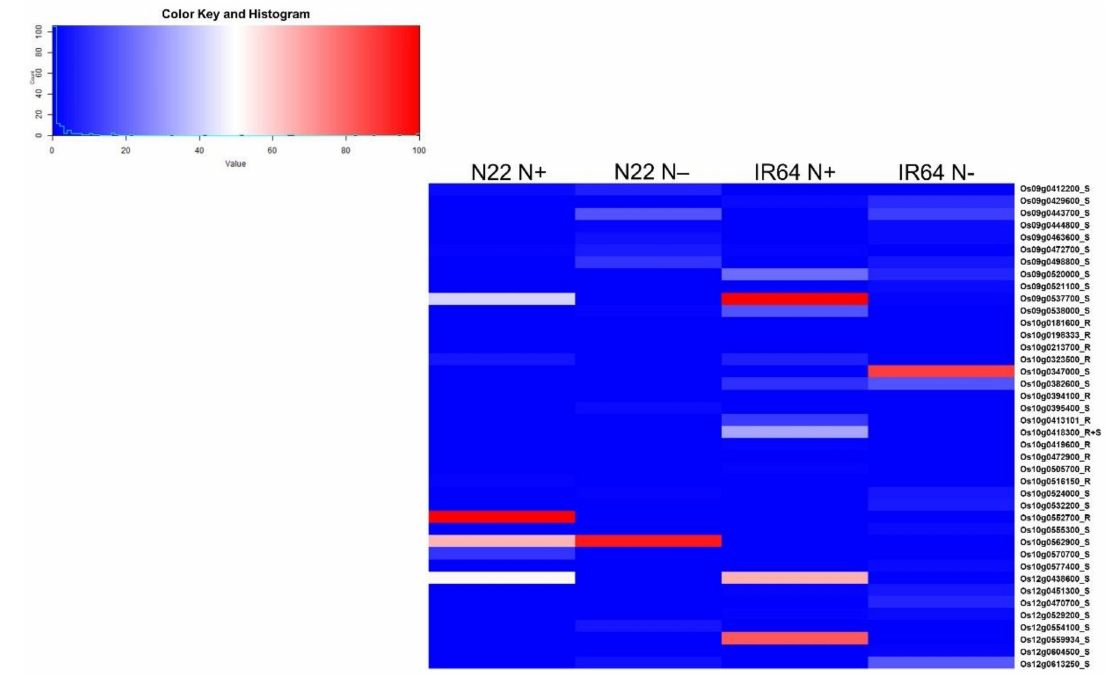
Figure 9. The expression patterns of the differentially expressed genes identified between two rice genotypes, Nagina 22 (N22) and IR64, from root and shoot tissues (DEGs from optimal N supply was the control) in the QTL intervals on chromosomes 9, 10, and 12. The heatmap represents the relative expression levels of 40 genes examined based on fragments per kilobase per million mapped reads (FPKM) values using RNA-seq